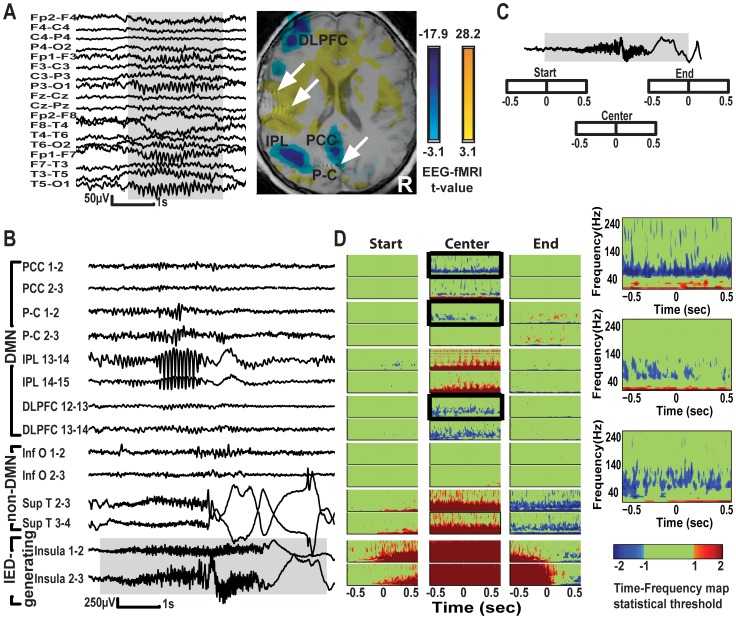
EEG-fMRI results and Time-Frequency (TF) statistical maps of SEEG recordings from patient 5.A – Scalp EEG showing electrographic seizure over perisylvian region and associated BOLD changes. Functional map is co-registered with anatomical MRI and CT showing the sampling of P-C, insula and temporal cortex by SEEG electrodes (marked by white arrows, other electrodes are not shown). Functional maps show activations in left insula and bilateral cingulate and deactivations in DMN nodes of left hemisphere. B - SEEG traces showing typical electrographic seizure originating from left insula (lower 2 traces) and SEEG in left PCC, P-C, IPL, DLPFC, inferior occipital and superior temporal regions. Each region was sampled with 2 consecutive bipolar channels 5 mm apart, and higher number denotes a more lateral channel. Note the spread of seizure activity to the IPL and temporal cortex and that the activity in IPL is identical to the activity measured on the scalp. C – Schematic representation of a typical electrographic seizure (not in scale) and 1 s epochs centered at the start, center, and end of the seizure. Epochs can overlap depending on the length of the IED. D – TF maps of statistically significant z values comparing start, center, and end of IED with baseline. They show decrease in gamma and increase in frequencies<30 Hz coinciding with the center of the seizure in PCC, P-C, DLPFC, whereas IPL and superior temporal gyrus show increase of frequencies up to 60 and 120 Hz, respectively, secondary to spread of epileptic activity. Boxed TF maps are shown in higher magnification on the right. Statistical threshold obtained after false discovery rate correction (indicated as “1” in color bar). Plots are saturated at a z value that is double the threshold value (indicated as “2”). Non-significant pixels (below false discovery rate threshold) are displayed in green.